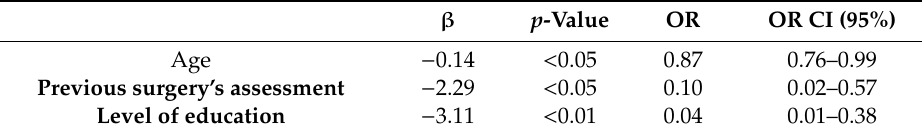
Table 3. Coe ffi cients of the binary logistic regression